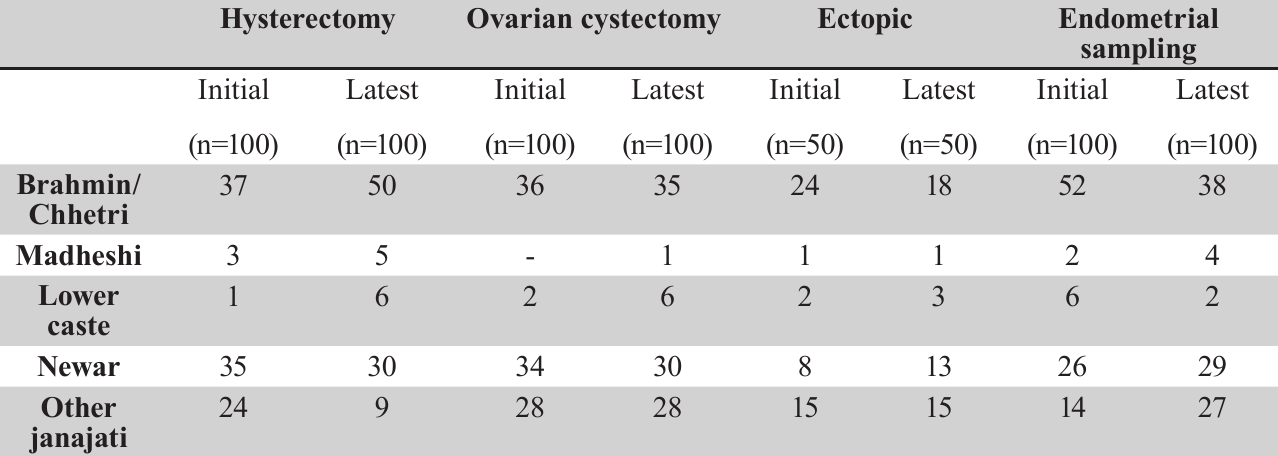
Table 1: Caste of operated